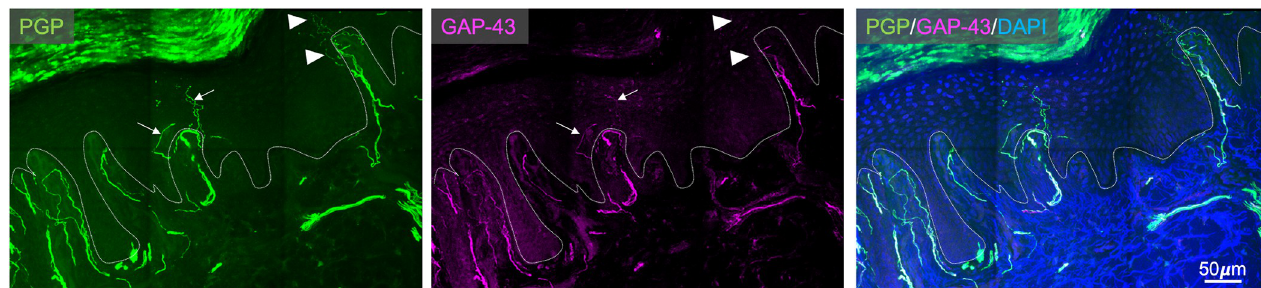
Fig 2. Example of skin immunostaining for PGP 9.5, GAP-43 and merged staining. Some PGP9.5+ intraepidermal nerve fibres are double labelled with GAP-43 (arrows) whereas others are not (arrow heads). The dermal-epidermal border is indicated with the dotted line.